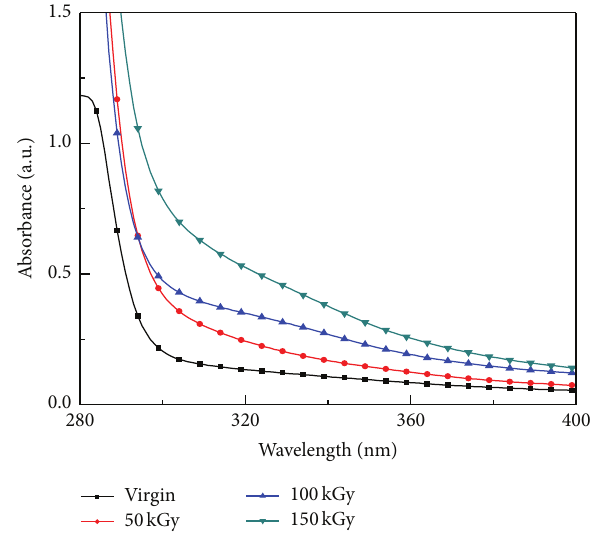
Figure 1: Absorption spectra of virgin and electron irradiated silk fibroin